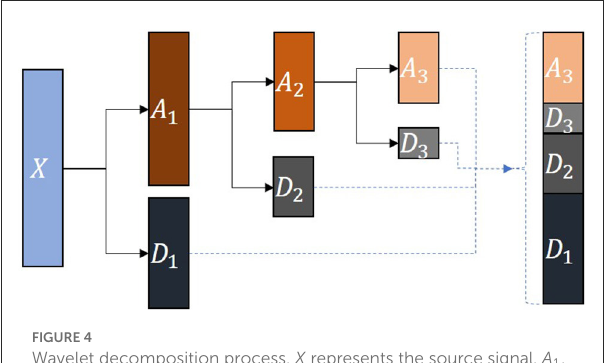
FIGURE4 Wavelet decomposition process. X represents the source signal. A 1 , A 2 and A 3 are the approximation coefficient arrays obtained by decomposing each layer. D 1 , D 2 and D 3 are the detail coefficient arrays obtained by decomposing each layer.